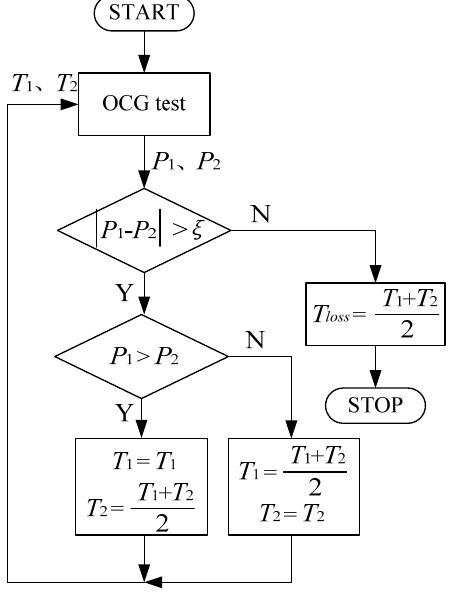
estimation loss